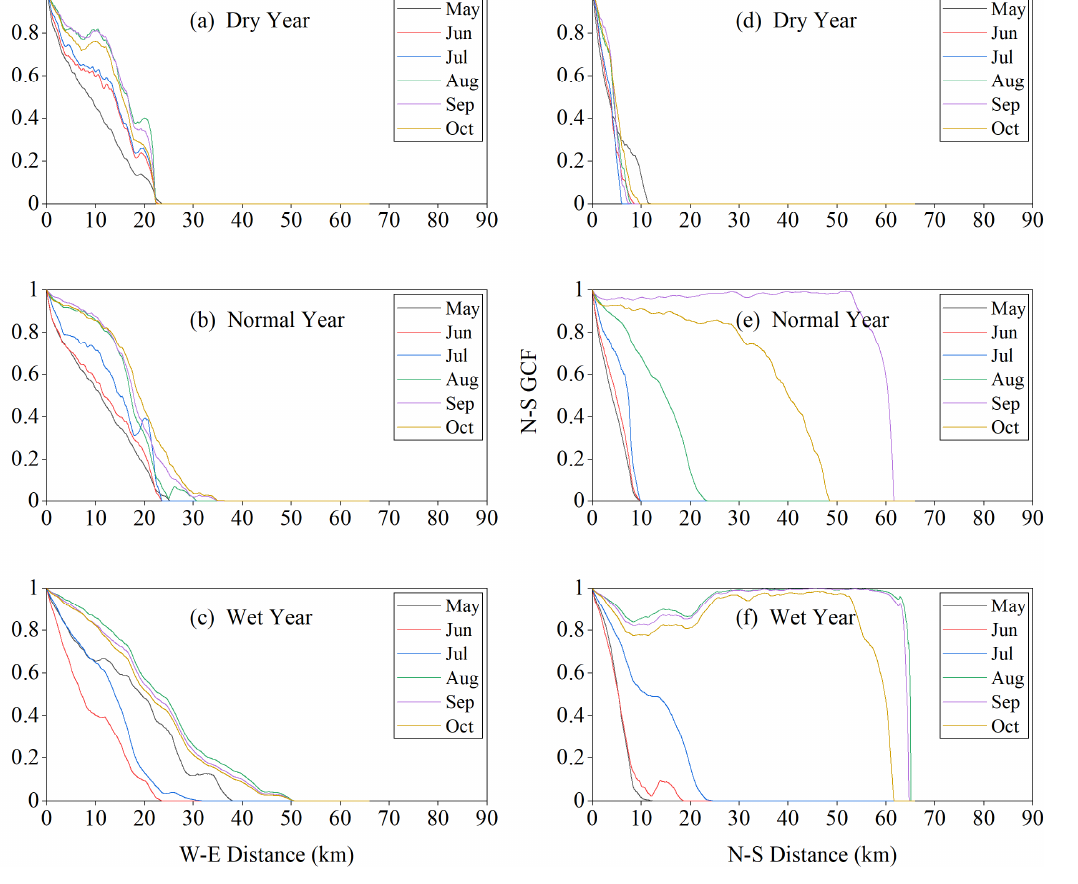
Figure 3. The relationship between geostatistical connectivity function (GCF) and maximum distance of connection (MDC) along the west–east (W–E) and north–south (N–S) directions of the multi-lake system in the Momoge National Nature Reserve (MNNR), China during different hydrological years. ( a ) W-E direction during a dry year, ( b ) W-E direction during a normal year, ( c ) W-E direction during a wet year, ( d ) N-S direction during a dry year, ( e ) N-S direction during a normal year, and ( f ) N-S direction during a wet year. Data source: The Joint Research Centre of the European Commission (EC JRC)/Google.